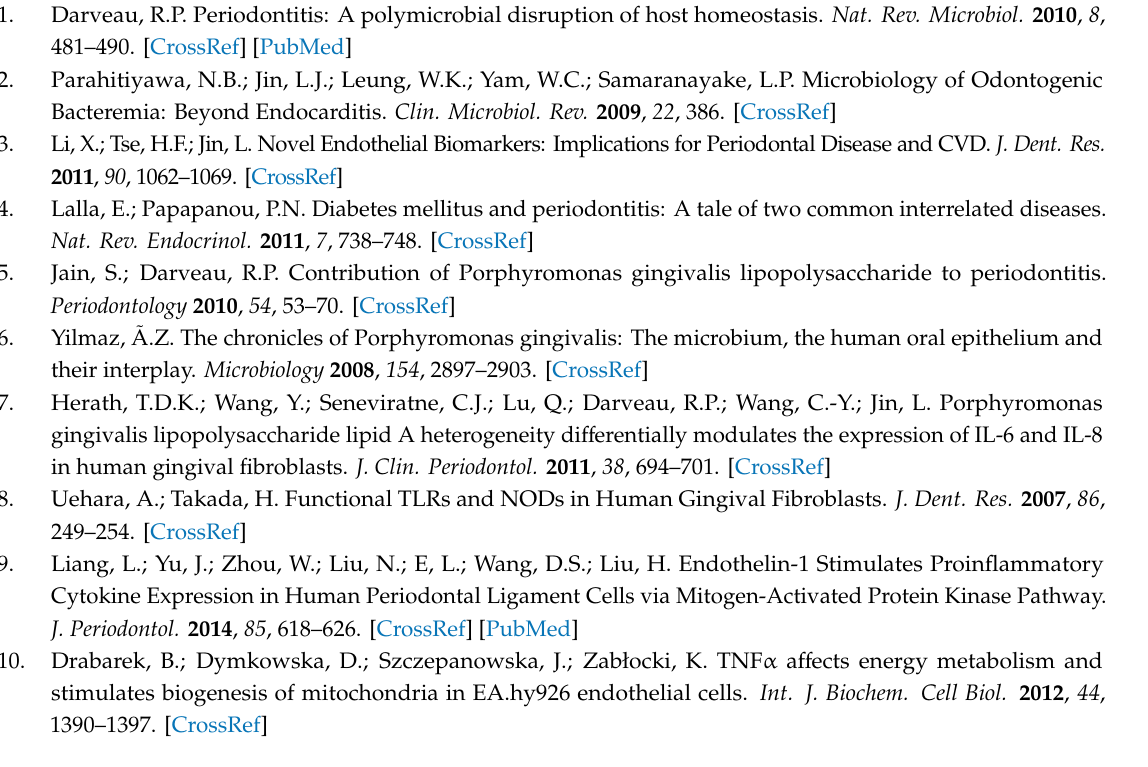
Supplementary Materials: The following are available online, Figure S1: Potential target candidates of Rb3 in mitogen-activated protein kinase (MAPK) signaling pathway from GO analysis, which are highlighted (in red